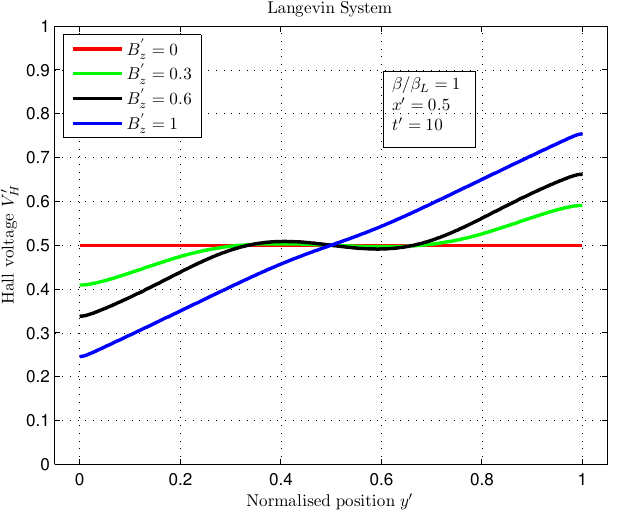
Figure 6. Hall voltage as a function of normalised position for varying magnetic fields in = Langevin system with β β L